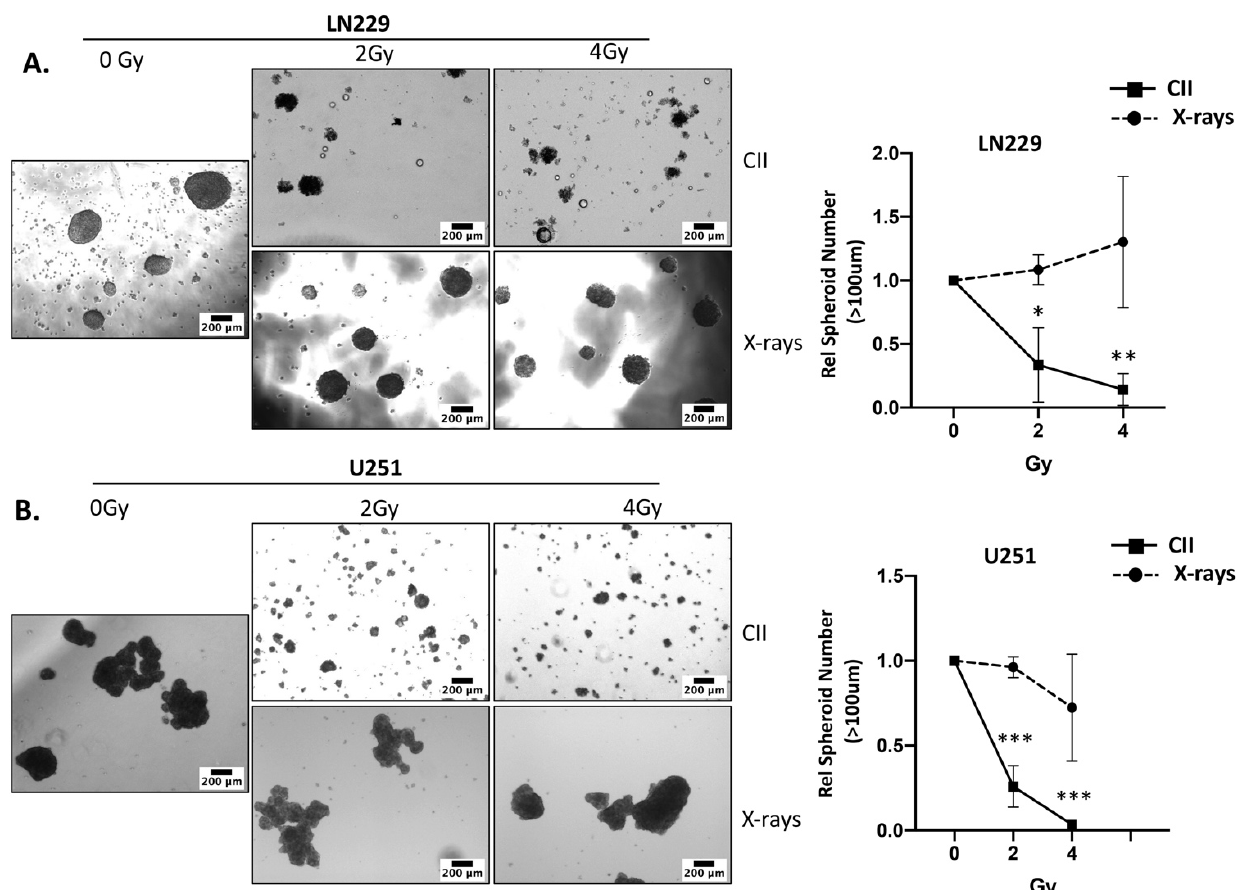
Figure 5. CII reduces the spheroid forming ability of LN229 and U251 glioma cell lines: Representative microscopic image of the spheroids formed by ( A ) LN229 and ( B ) U251 at day 14 post irradiation with CII or X-rays (scale bar in black = 200 μm). (( A ), right)(( B ), right) Relative spheroid number derived from ( A , B ). Each experiment was carried out in triplicate. Data are from 3–4 independent experiments and presented as mean ± SD. Statistical analysis was performed by ANOVA with Bonferroni post-hoc test. p -values (* p < 0.05, ** p < 0.01, *** p < 0.001).